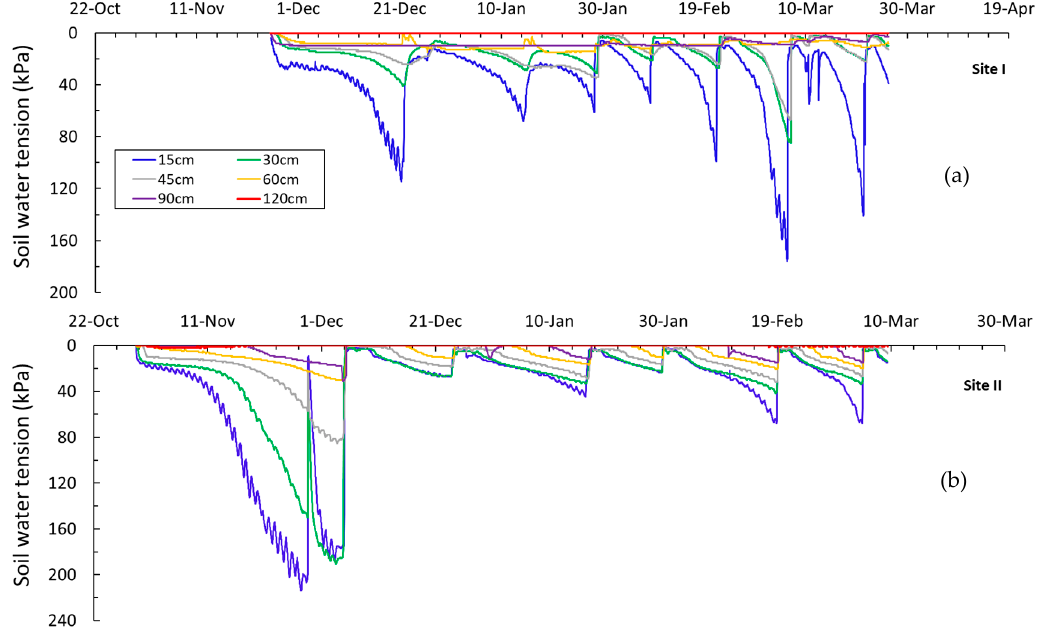
Figure 5. Half-hourly soil water tension measured at multiple depths of 15, 30, 45, 60, 90, and 120 cm at Sites I (sprinkler irrigation) ( a ) and II (furrow irrigation) ( b ) over the growing seasons.